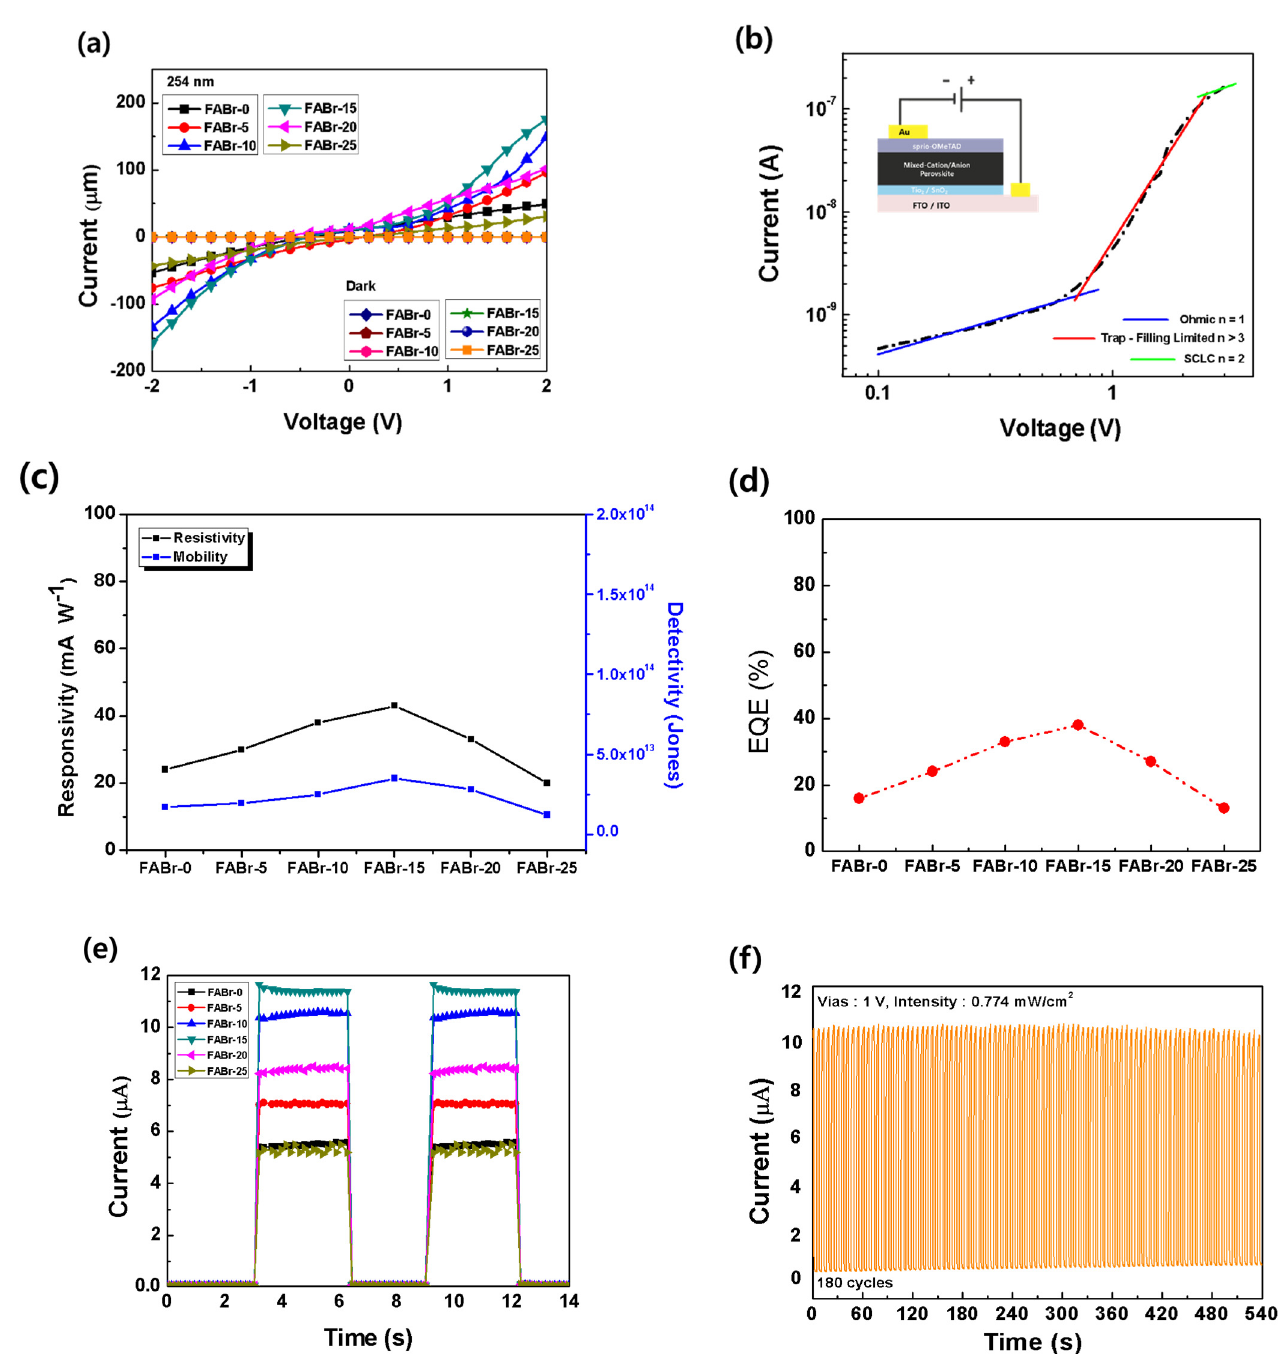
(SCLC) region, the current is approximately proportional to (cid:1848) 2+ (cid:1866) , where n is the improve ‐ ment factor due to trap filling. In addition, a saturation of the photocurrent occurs due to the Schottky contact formed between the electrodes [43].